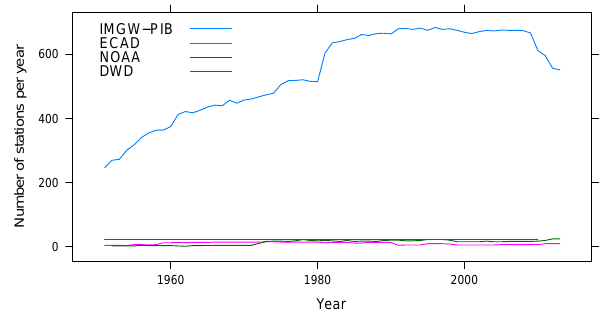
Figure 2. Number of meteorological stations for precipitation ob- servations per year from 1951 to